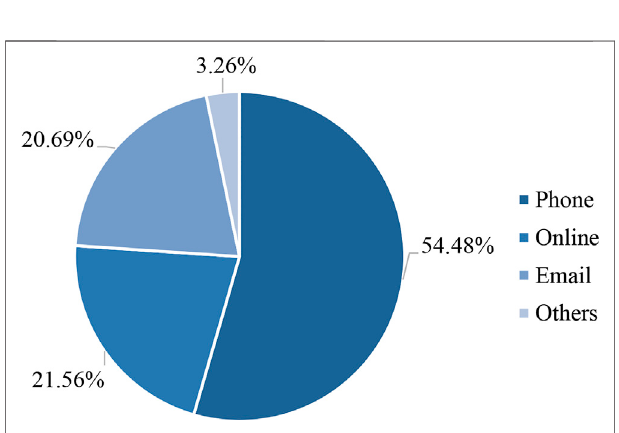
FIGURE 4 | Types of receipts for construction-related